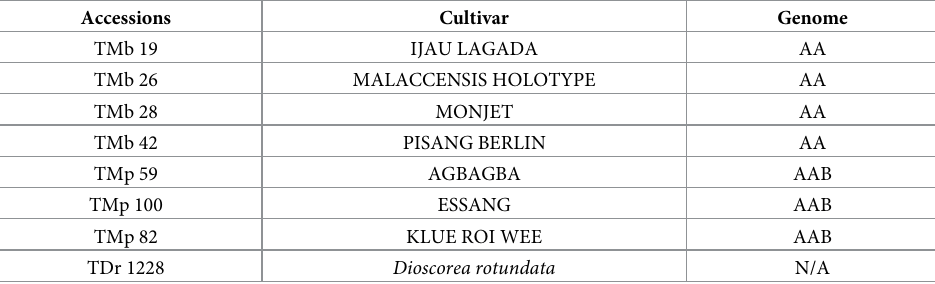
Table 1. List of accessions of Yam and Musa with genome information and cultivar